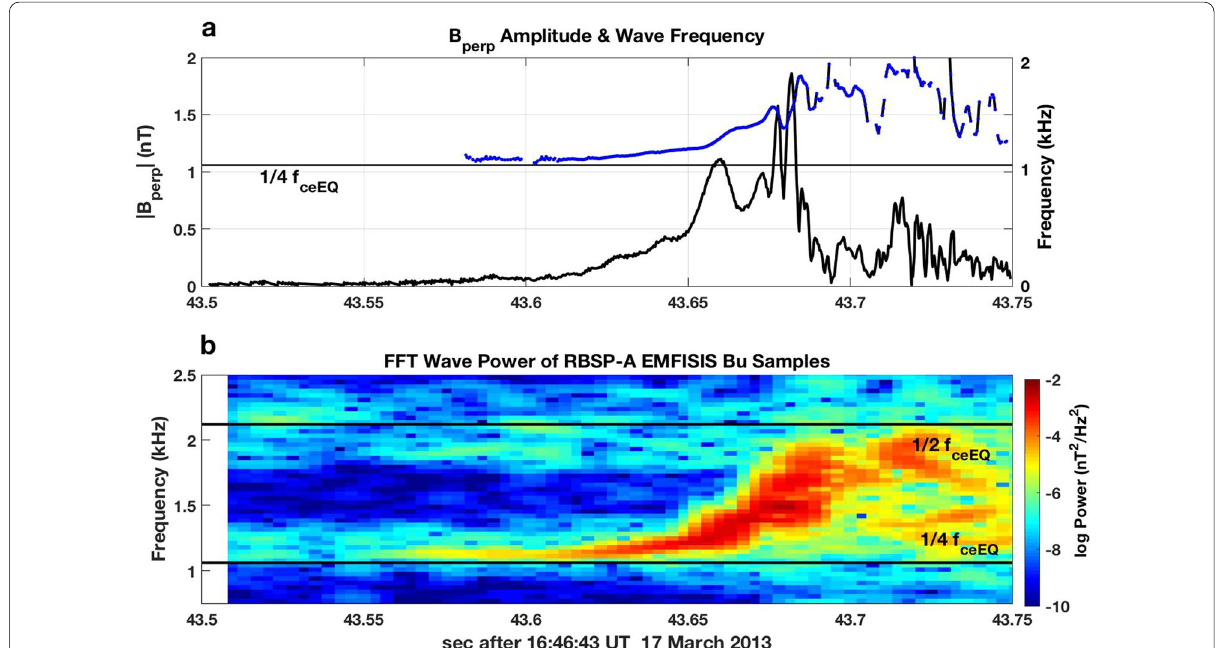
Fig. 1 The analysis of Van Allen Probes EMFISIS high-frequency wave magnetic field observations of a strong VLF chorus element observed during the 17 March 2013 event reveals the typical subpacket structure and relationship between wave amplitude and frequency. The RBSP-A spacecraft was at L ~ 5, ~ 02 MLT, and at a position ~ 4° off the equatorial plane. a Wave frequency (blue) and perpendicular wave magnetic field amplitude (black) are shown across the multiple subpackets comprising the chorus element. b The wave magnetic field spectrogram shows an extended (> 80 ms) period of gradually increasing wave power and frequency before the onset of the first strong subpacket at 43.65